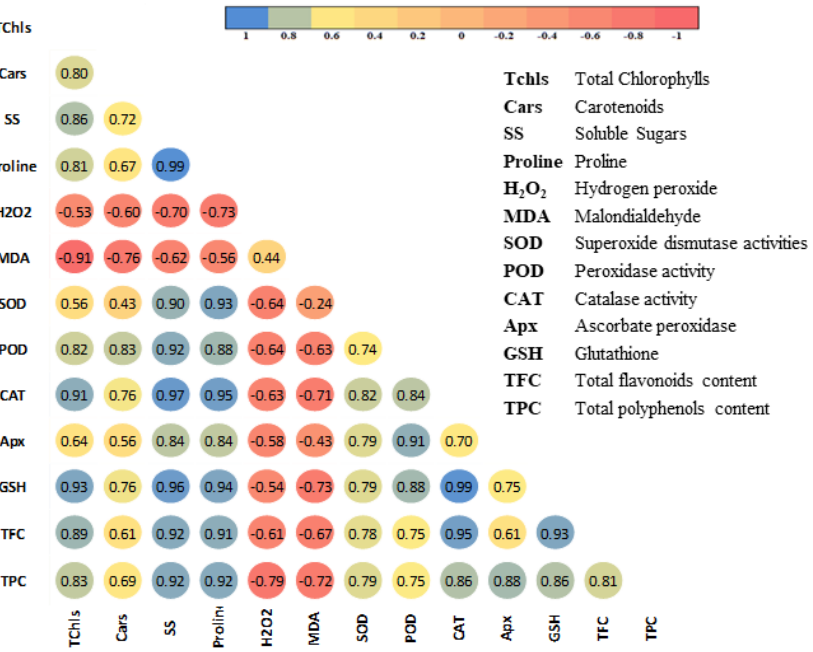
Figure 8. Pearson’s correlation analysis of different physiological and biochemical traits under cold low-temperature stress treatment.